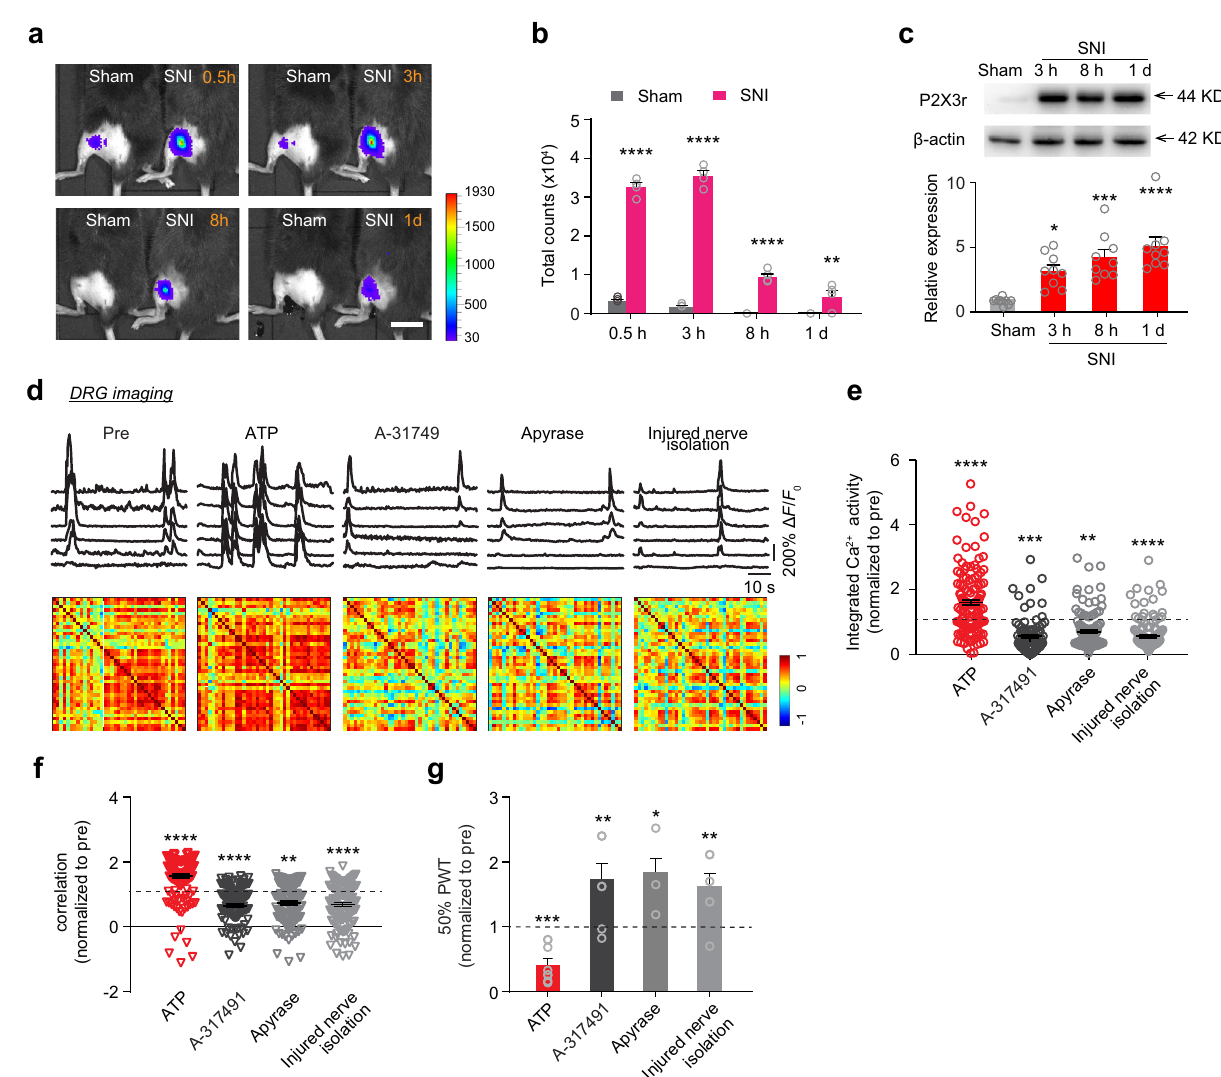
Fig. 4 | ATP at the site of injury is important for synchronized DRG neuronal activity after SNI. a Representative images of ATP release detected by biolumi- nescence0.5,3,8,and24hoursaftershamorSNIsurgery.Scale,20mm.Thecolor bar is luminescence signal in counts. b The level of luminescence signal from the injured zone at various time points after sham or SNI surgery. c Western blot analysis of the expression of P2X 3 receptor in the injured nerves from SNI mice. d – f Representative fl uorescence traces and correlation matrices ( d ) as well as